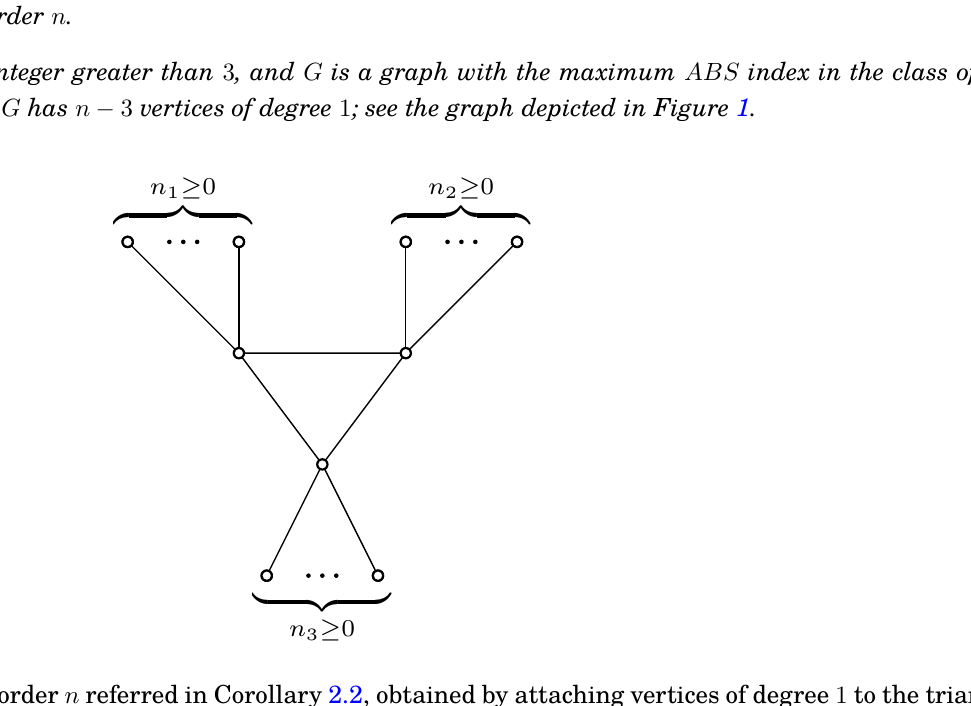
Figure 1: The unicyclic graph of order n referred in Corollary 2.2, obtained by attaching vertices of degree 1 to the triangle C 3 . Here, n 3 ≥ n 2 ≥ n 1 ≥ 0 and n 1 + n 2 + n 3 = n − 3